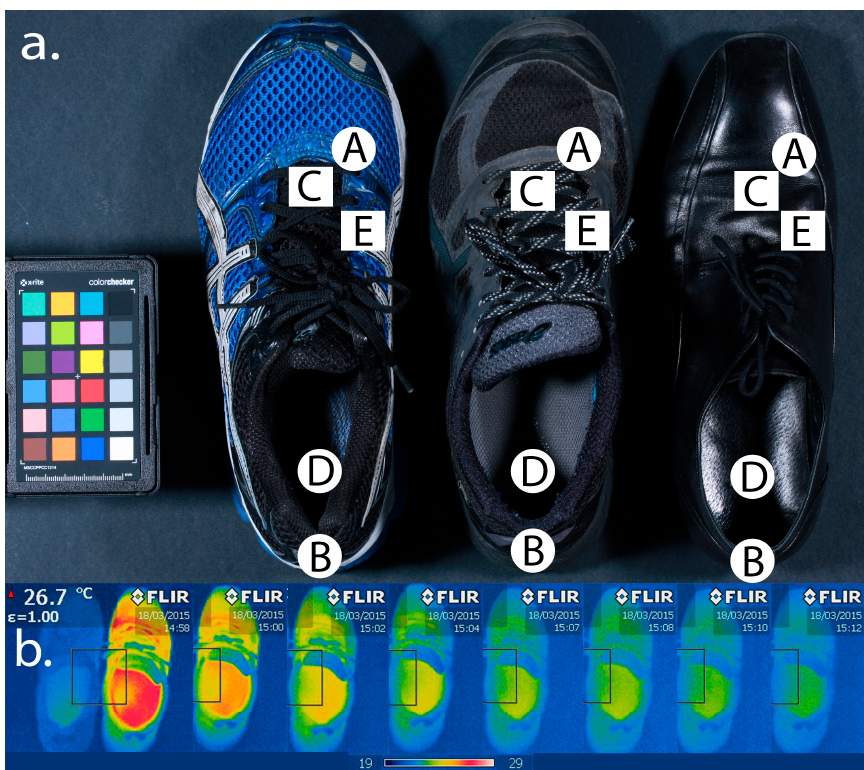
Figure 2. ( a ) Temperature sampling points on three adult male shoes and ( b ) representation of shoe cooling in pilot studies. See text and Figure 3 for quantitative analysis. Points A–E represent temperature sampling points with Therm-Micro probes on points A (External Toe); B (External Heel); C (Internal Toe); D (Internal Heel); E (Internal Point). Circular boxes represent sampled point on the surface of shoe, square boxes represent points internally sampled.